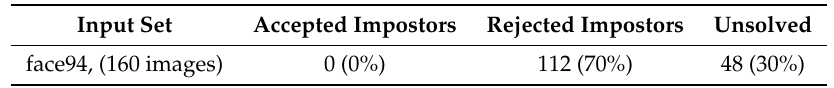
Table 3. Face recognition acceptance rates for impostor subjects.